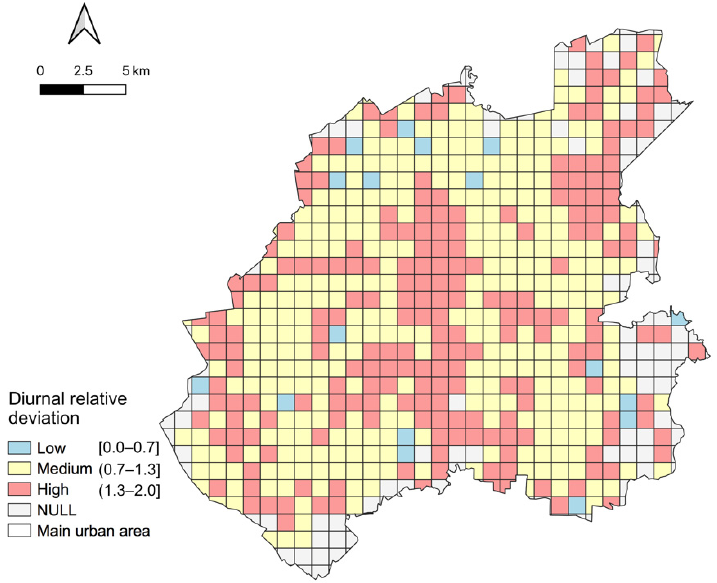
Figure 7. Spatial distribution of diurnal relative deviation.